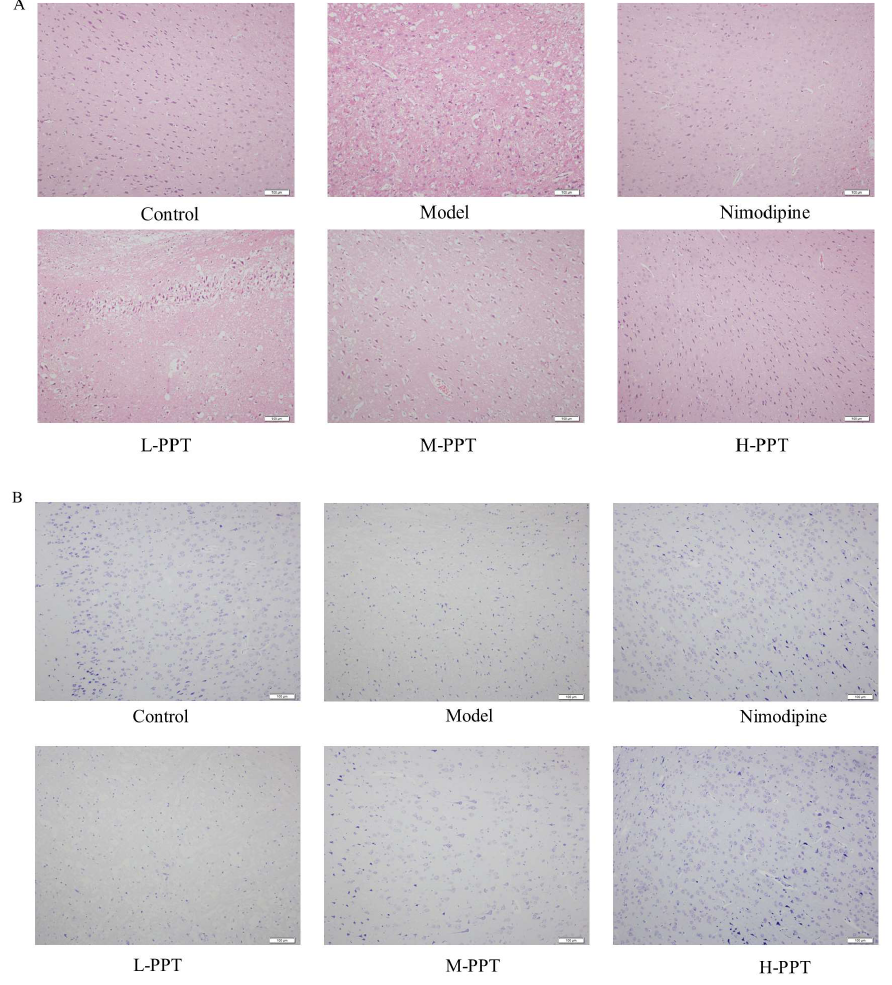
Figure 4. Detection of brain tissue injury in different groups. The representative histopathological changes in different groups by HE staining and Nissl staining method ( A , B ), Scale bar = 100 µ m ( n =